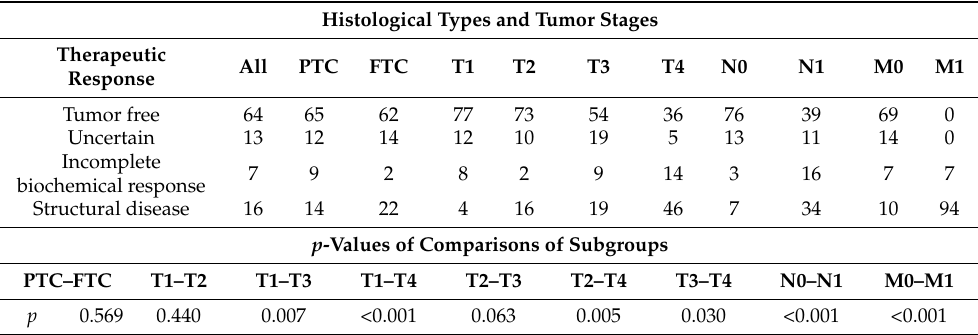
Table 2. Therapeutic response rates (%) according to histological types and tumor stages and p -values of comparisons of subgroups (in Kruskal–Wallis tests).